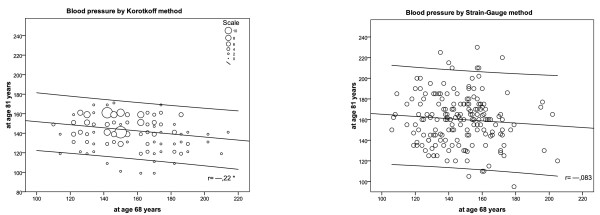
Correlation between Korotkoff blood pressure (K-BP) at age 68 and at age 81 (left), and between Strain Gauge blood pressure (SG-BP) at age 68 and at age 81 (right). Regression lines with 95% confidence intervals.